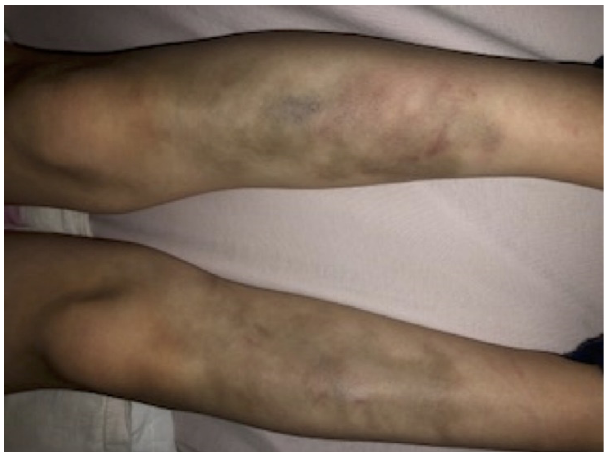
Figure 3. Pretibial findings. Easy bruising is a common clinical manifestation of both classical and periodontal EDS and can occur anywhere on the body, including unusual sites like the cheeks. The pretibial area often remains stained with hemosiderin from previous bruises.